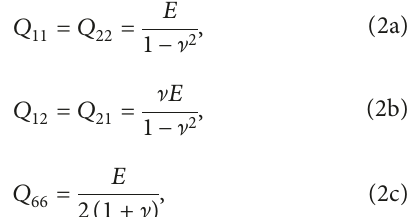
Figure 2: Differential element of spherical